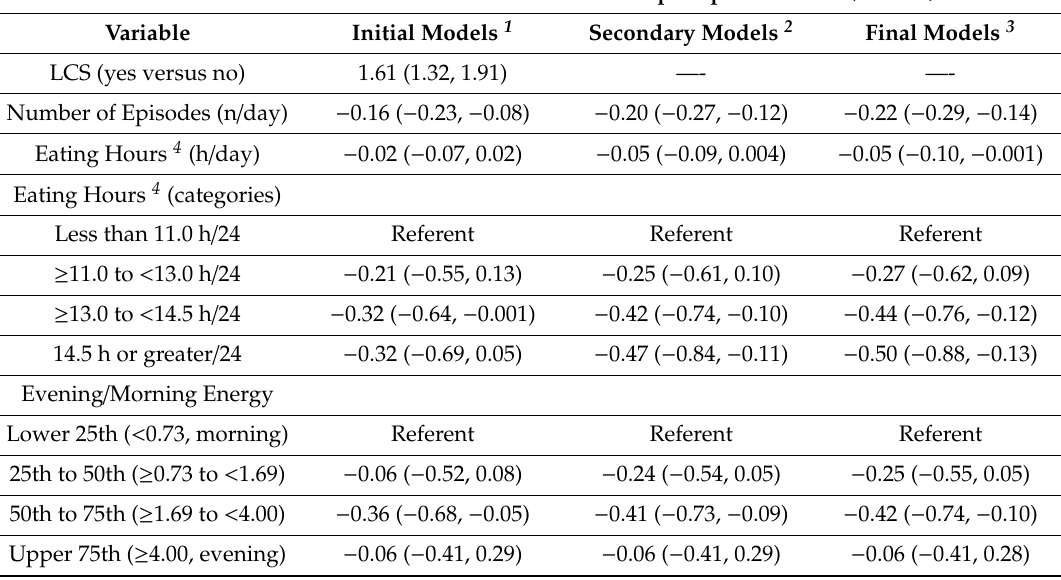
Table 3. Estimated mean BMI di ff erences per indicated unit of each variable after adjustment as specified for each model. Separate models were run for each variable (NHANES 2007–2016).